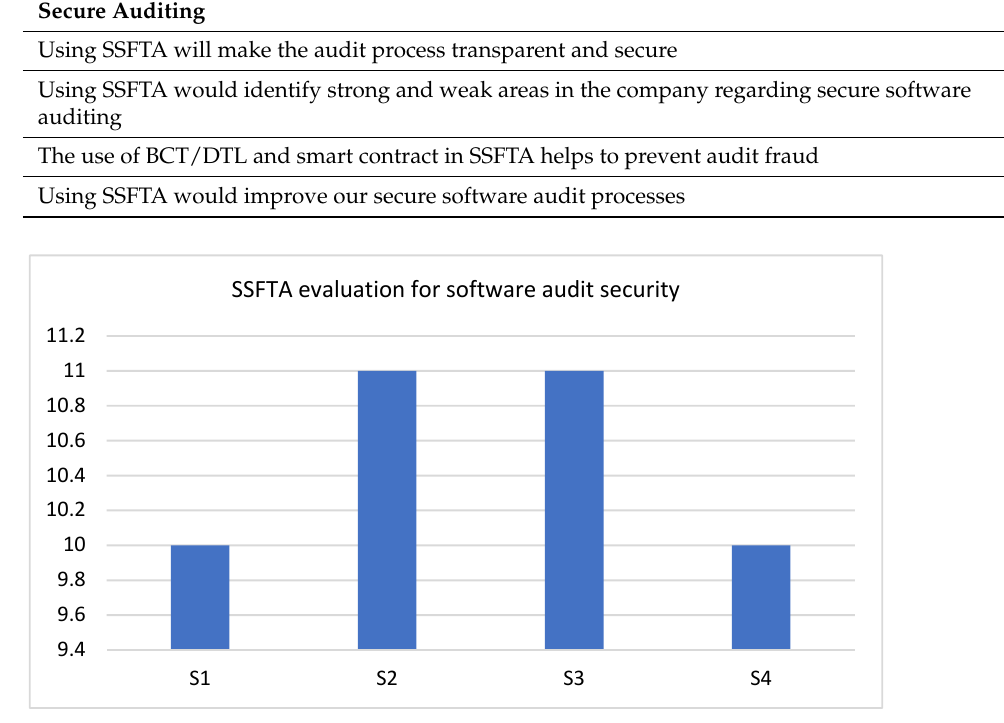
Table 4. The questions to evaluate SSFTA secure auditing characteristics .